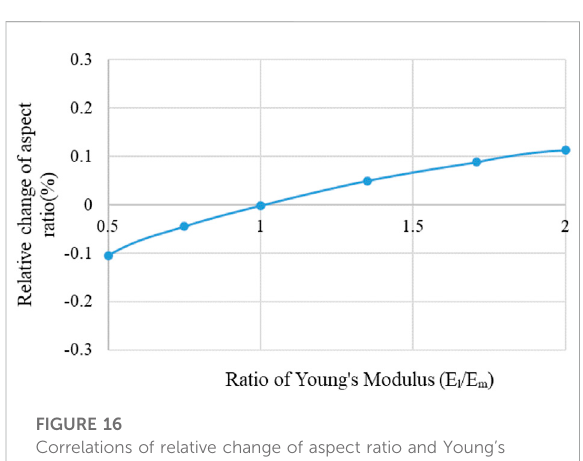
FIGURE 16 Correlations of relative change of aspect ratio and Young ’ s modulus ratio of adjacent layers in uncon fi ned fracture model ( υ m = υ l =0.25, ε xx (ave)=0.002, H/T l =0.1, T l =0.2m, T m =0.3 m).